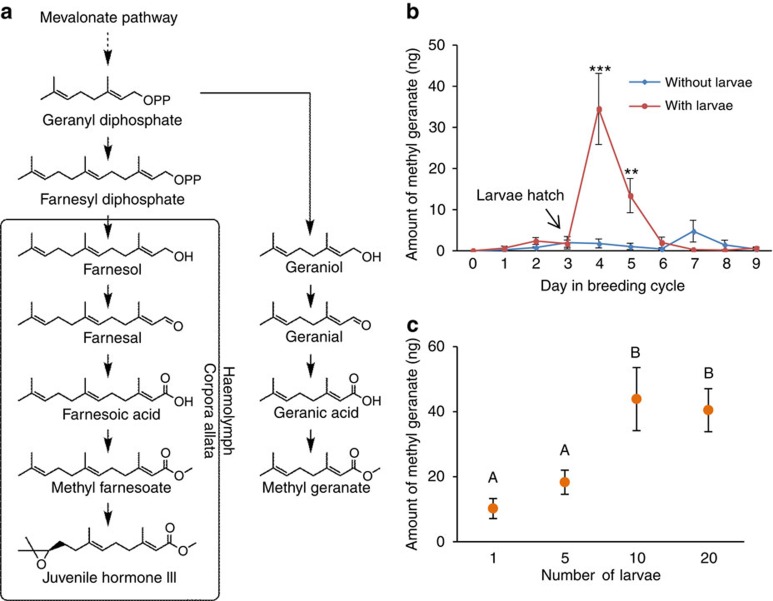
Methyl geranate biosynthesis and emission.(a) Putative biosynthesis of methyl geranate and its link to JH III. (b) Methyl geranate emission in ng per individual per 20 min (mean±s.e.) over an entire breeding cycle. Females were either allowed to care for their larvae (with larvae; N=170) or withheld from their hatched larvae (without larvae; N=169). There was an interaction effect of treatment group and day (Gaussian GLM: F9,319=11.35, P<0.0001). Note: on day 3 larvae hatched, but had not yet arrived on the carcass. (*P<0.05, **P<0.01, ***P<0.001). (c) Amount of methyl geranate (mean±s.e.) emitted over a period of 20 min by mothers caring for 1, 5, 10 or 20 larvae. Different letters represent significant differences (Gaussian GLM following Benjamini–Hochberg; N=20–30).